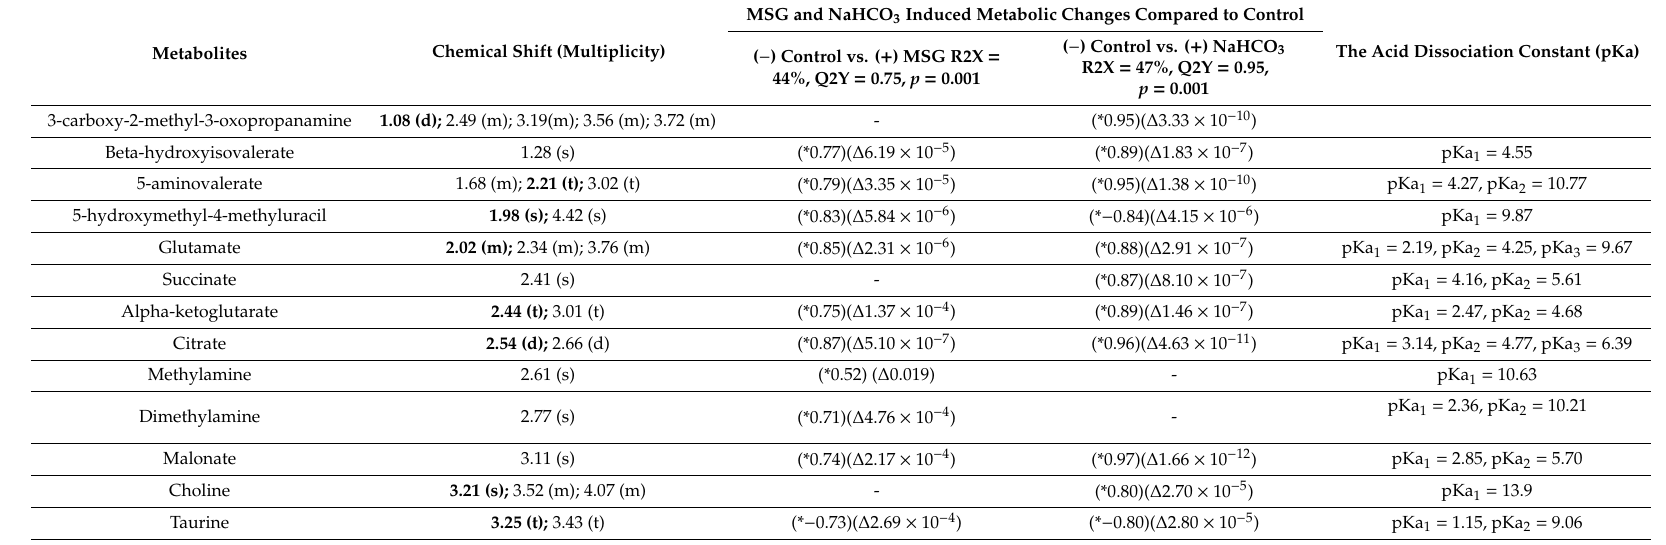
Table 2. Relative changes at 2 weeks of 24 h urine metabolites in control, MSG and NaHCO 3 rats ( n = 10 per group) using the 1 H-NMR profiles.